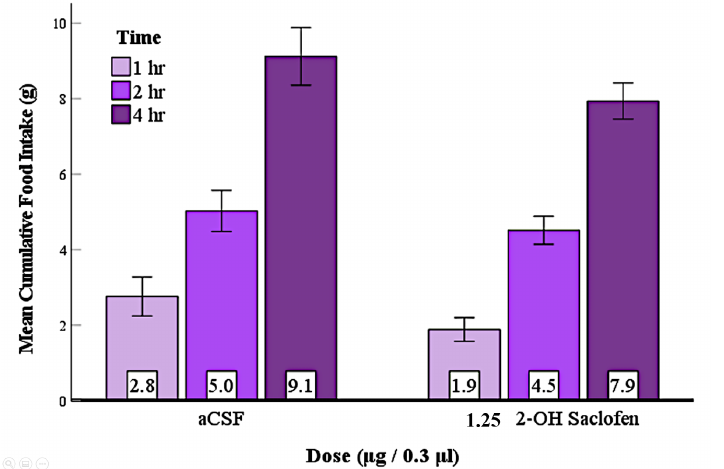
Figure 7. 2-OH saclofen injection into the LS at the beginning of the dark phase did not significantly suppress natural feeding. Error bars: ±1 SEM; n = 12; mean values are shown at the bottom of the